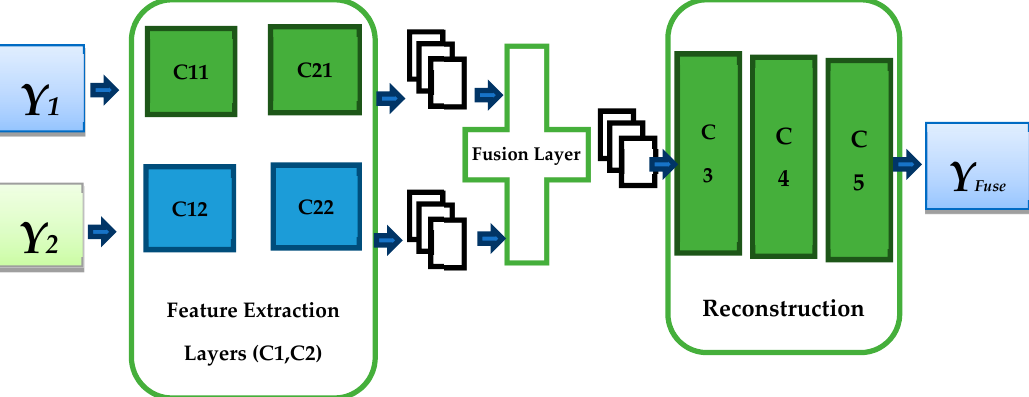
Figure 9. Illustration of the fusion process of image pairs.